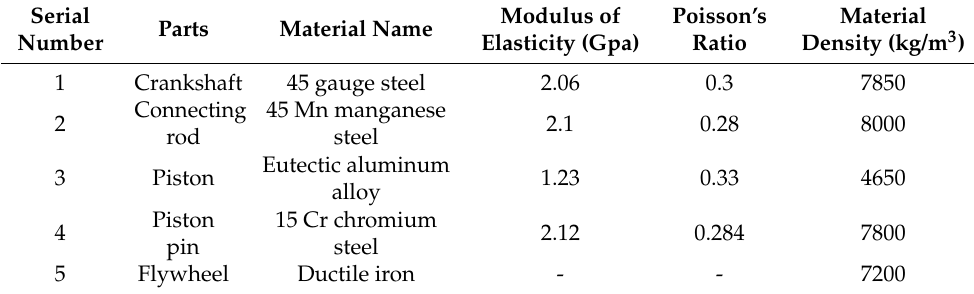
Table 4. Material parameters of each component of the shaft system.